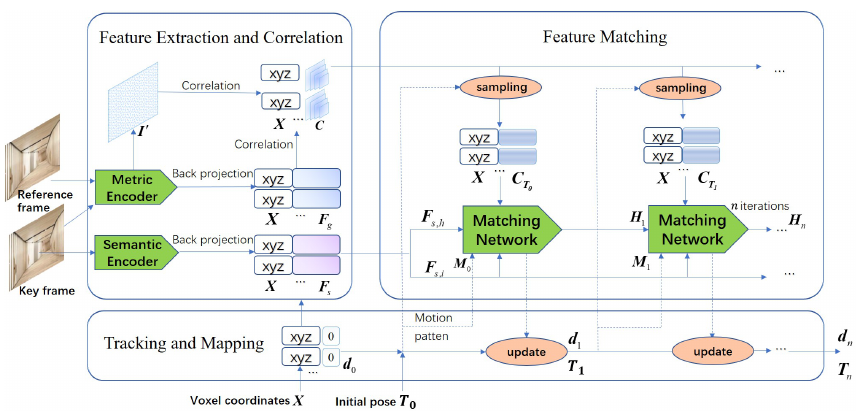
Figure 2. The structure of